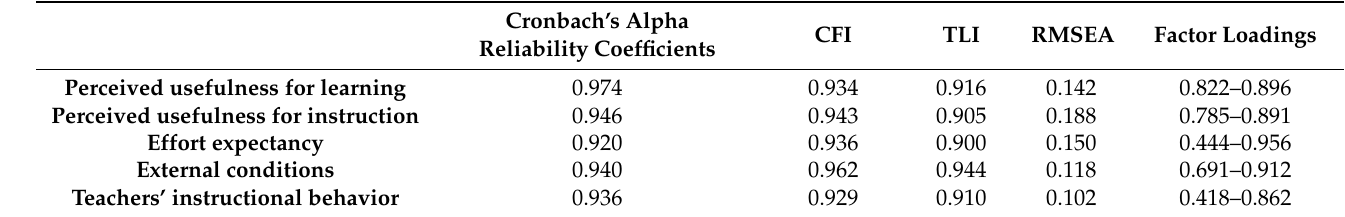
Table 2. The Cronbach’s alpha reliability coefficients and CFA model fit of the predictive and outcome